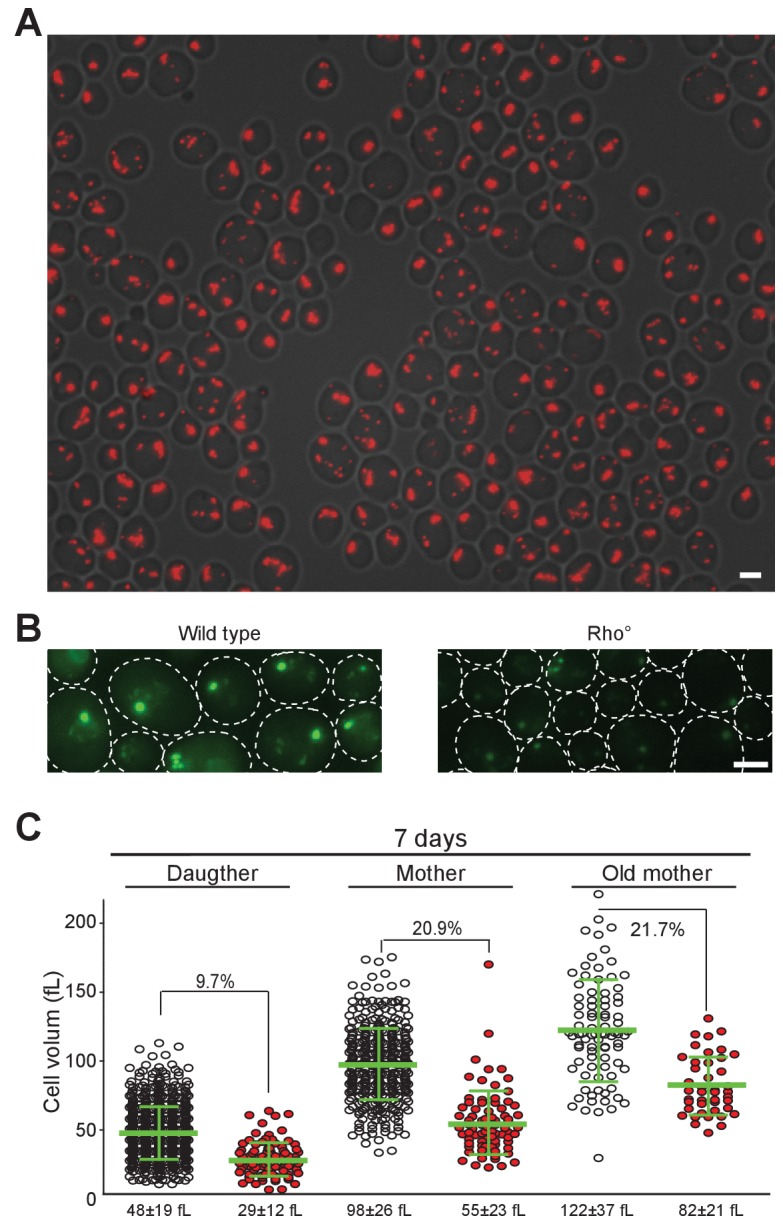
Actin and Proteasome localization in WT and rho zero cells, cell volume variation according to mitochondrial network organization.(A) Actin phalloidin staining of WT prototroph rho zero cells after 24 hr of culture in YPD. The image is a superposition of the DIC and the RFP channel. (B) Proteasome (Scl1-GFP) localization in WT and WT rho zero cells after 6 d in YPD. Bars are 2 μm. (C) Cell volume of daughter, mother and old mother (>5 bud scars) cells after 7 d in YPD according to their mitochondria organization. The median cell volume and the percentage of cells with globular mitochondria (in red) within each sub-population are indicated.10.7554/eLife.35685.018Figure 5—figure supplement 1—source data 1.Cell volume measurements in daughter and mother cells depending on their mitochondrial network organization (panel C).